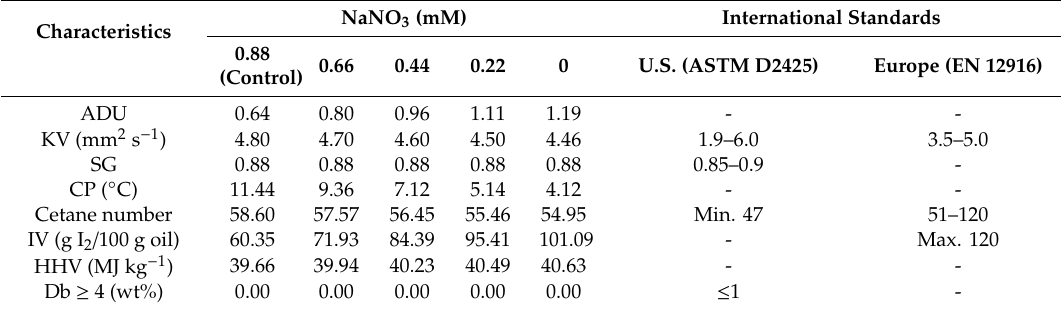
Table 3. Characteristics of biodiesels produced by Tisochrysis lutea grown mixotrophically in di ff erent concentrations of NaNO 3